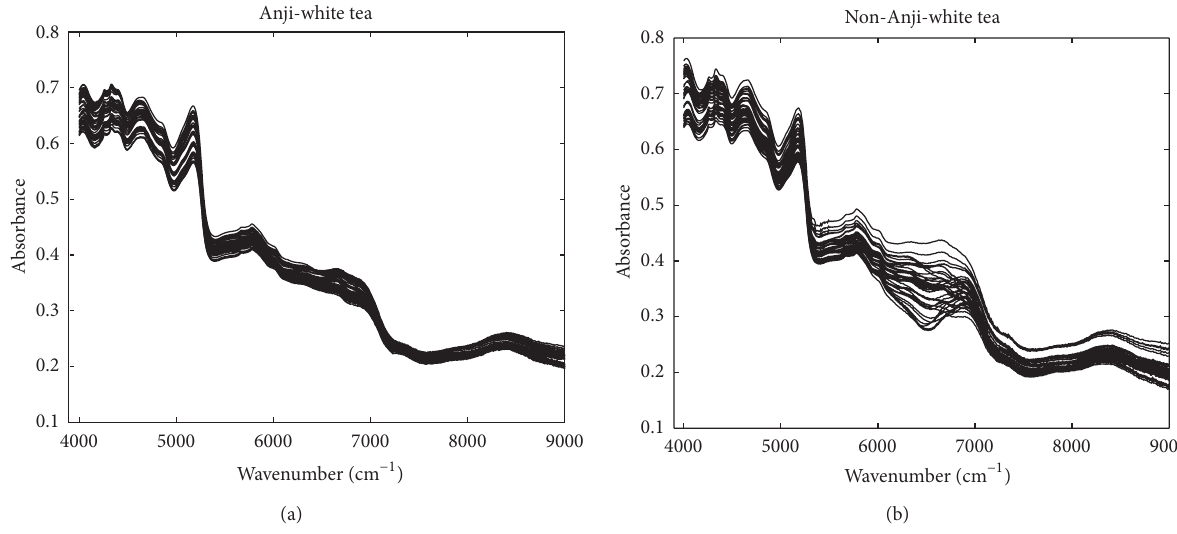
F 1: Some of the NIR spectra of real Anji-white (a) and non-Anji-white (b) tea